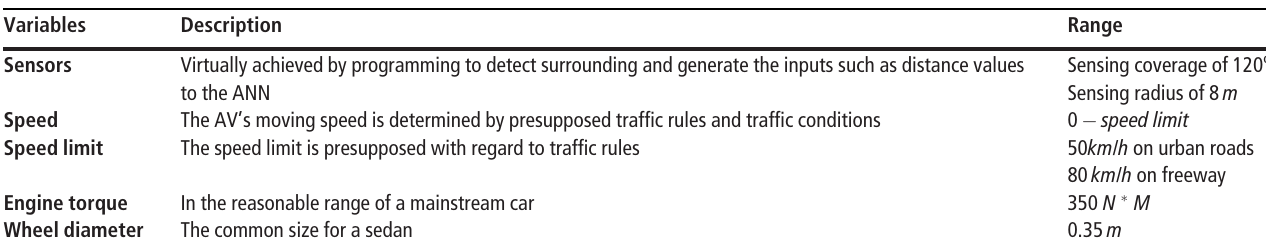
Table 1 The AV ’ s key